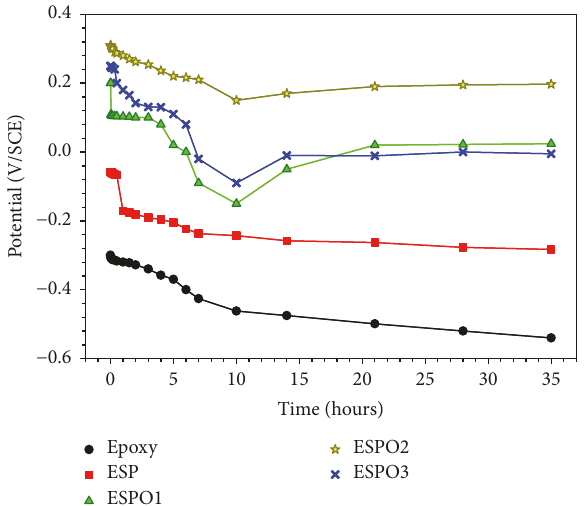
Figure 6: Open circuit potential of coated steel samples during immersion time in 3% NaCl solution.